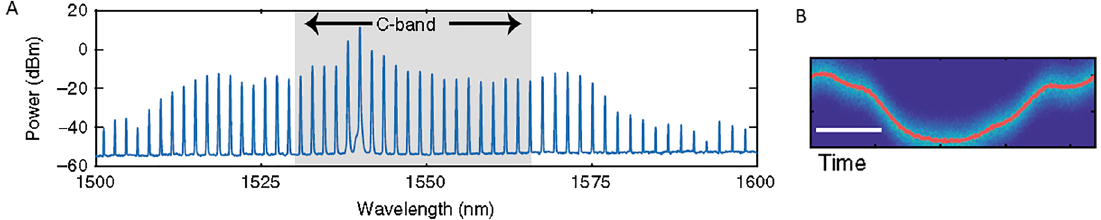
Figure 10: Dark pulse micro-comb. (A) Optical spectrum of the dark pulse micro-comb. (B) Directly measured intra-cavity time-domain waveforms. Reprinted (adapted) with the permission from Ref. [25], Copyright 2018, Springer